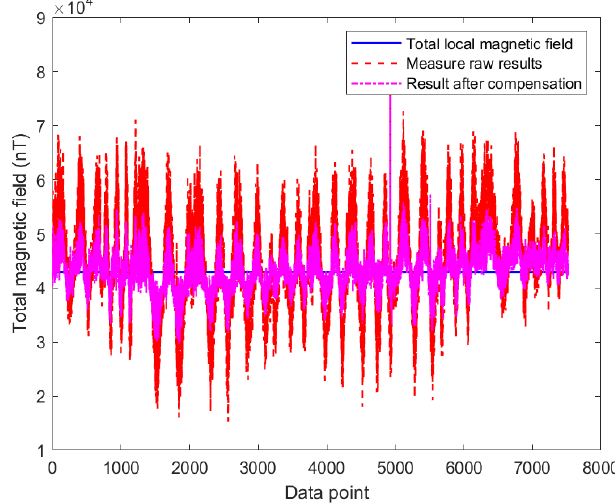
Figure 8. Compensation algorithm effect.